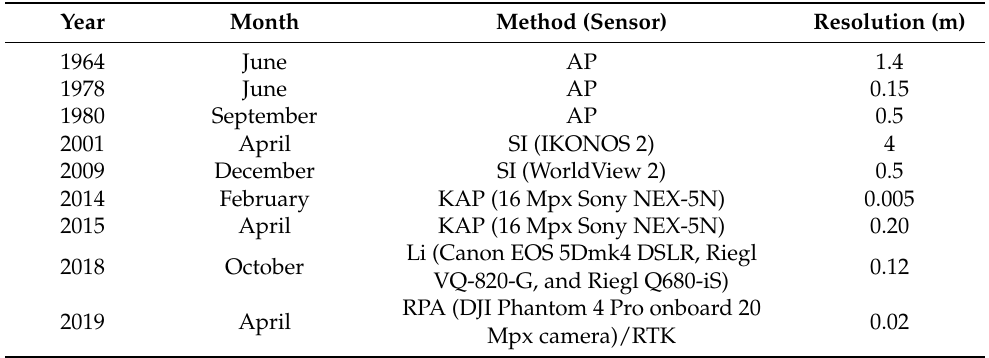
Table 1. Dates, sensors, and resolution of some of the datasets used to investigate geomorphic changes at OTI. AP: Aerial Photo; SI: Satellite Image; KAP: Kite Aerial Photography; Li: Light Detection and Ranging; RPA: Remotely Piloted Aircraft System. Month Method